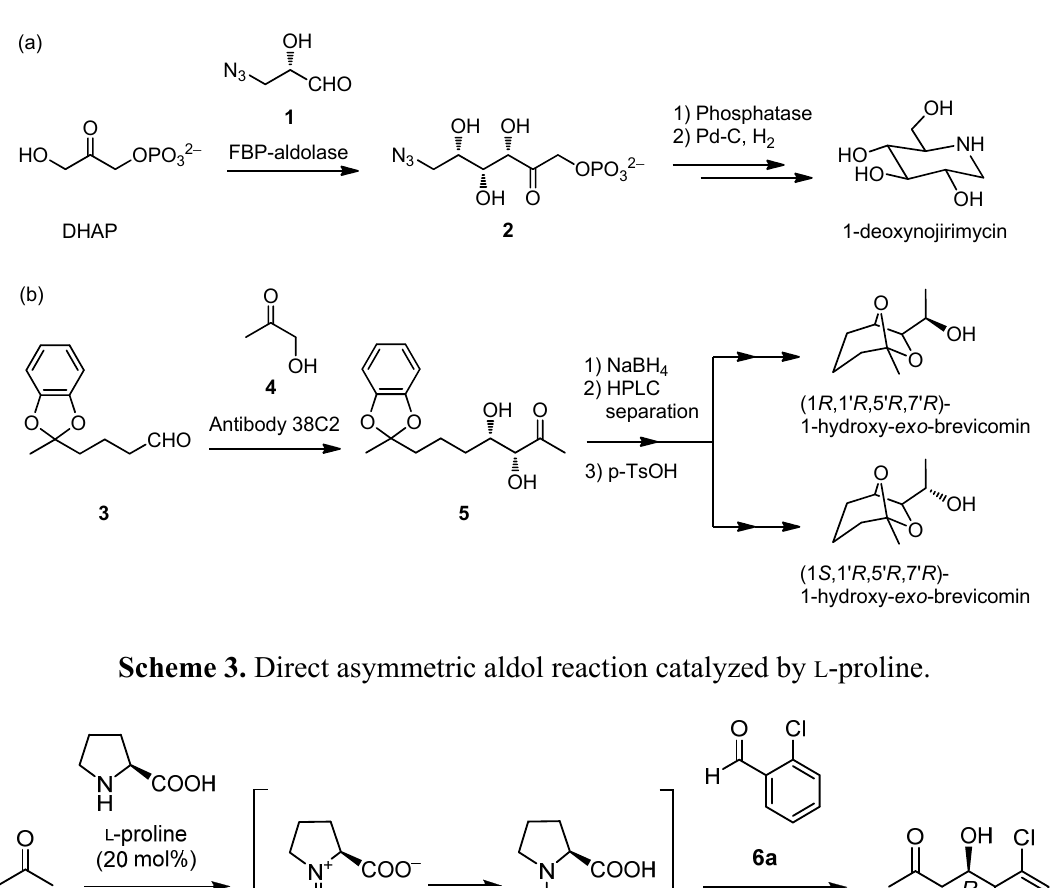
Scheme 2. Examples of aldol reactions using ( a ) FBP-aldolase and ( b ) aldolase antibody 38C2.